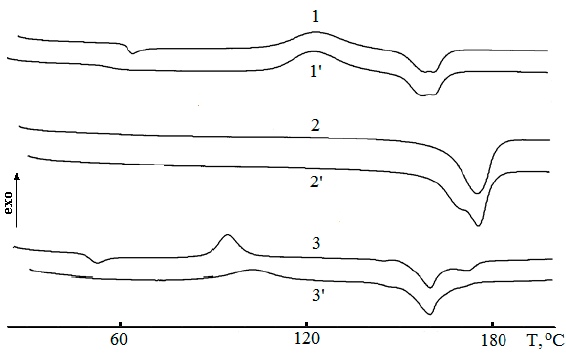
Figure 1. Di ff erential scanning calorimetry (DSC) curves of PLA ( 1 , 1 (cid:48) ), PHB ( 2 , 2 (cid:48) ), and their blend Figure 1. Differential scanning calorimetry (DSC) curves of PLA ( 1 , 1 ′ ), PHB ( 2 , 2 ′ ), and their blend with PEG (PLA–PHB (80: 20 wt %) + 5 wt % PEG 400 ) ( 3 , 3 (cid:48) ) at the first (without prime) and second with PEG (PLA − PHB (80: 20 wt %) + 5 wt % PEG 400 ) ( 3 , 3 ′ ) at the first (without prime) and second (primed) (primed) heating.